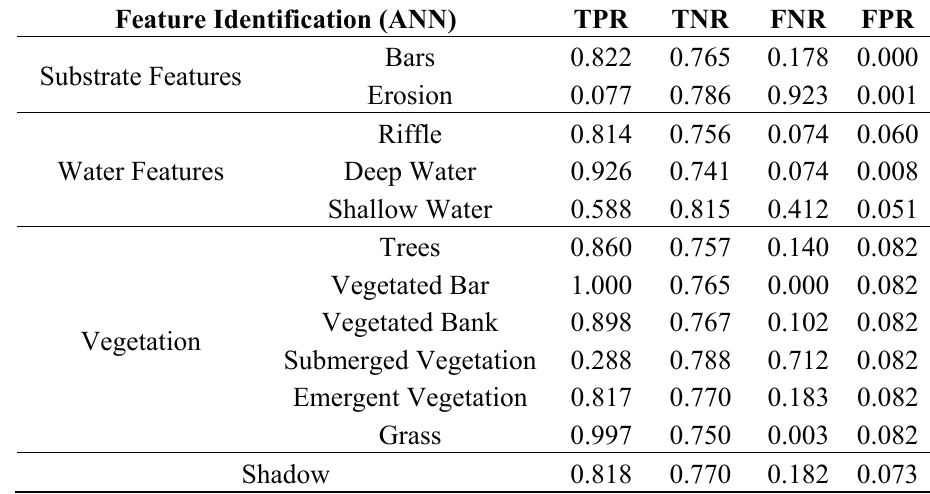
Figure 4. Example of trained outputs for ( a ) Vegetation in bars; ( b ) Side bars with no vegetation; ( c ) Trees; ( d ) Erosion and ( e ) Riffle. The outputs portray the portion of the imagery selected for analysis and the pixels selected (pink) by the cluster algorithm. Table 4. True positive ratio (TPR), true negative ratio (TNR), false negative ratio (FNR) and false positive ratio (FPR) for each of the class features identified by the Artificial Neural Network (ANN) within the river